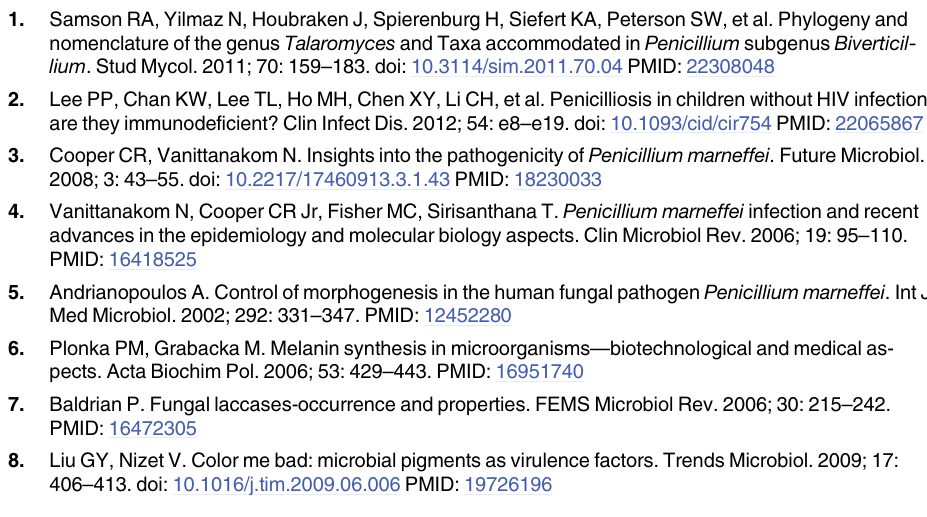
S1 Fig. Patterns of copper binding sites in T . marneffei MCOs. Sequence alignments show- ing the general copper signature sequences (L1 – L4) found in fungal laccases [34, 35]. Site of the first amino acid of each sequence is indicated next to PMAA number. The copper binding residues are highlighted and note the type of copper (1, 2, and 3). Asterisk is a potential proton donor. Type 1 copper ligand (M/L/F) superscripted with I/II/II refers to redox potential class from low to high [35]. S2 Fig. Schematic of the putative gene cluster involved in conidial pigmentation. (A) Geno- mic region in T . marneffei (Tm) from gene PMAA_082000 to PMAA_08120, which encom- passes a cluster of genes, predicted to be required for conidial pigment synthesis. Genes required for conidial pigment biosynthesis are colored brown (PMAA_082010 oxidase, abrA ), blue (PMAA_082020 aygA ), orange (PMAA_082030 1,3,6,8-tetrahydroxynaphthalene reduc- tase, arpB ), aqua (PMAA_082040 scytalone dehydratase, arpA ), red (PMAA_080260 laccase, pbrB ) and green (PMAA_080260 polyketide synthase, wA ). (B) A . fumigatus gene cluster in- volved in DHN melanin synthesis. This gene cluster is conserved in A . fumigatus (Af) (AFUG_2G17530, abr2; AFUG_2G17540, abr1 ; AFUG_2G17550 ayg1 ; AFUG_2G17560 arp2